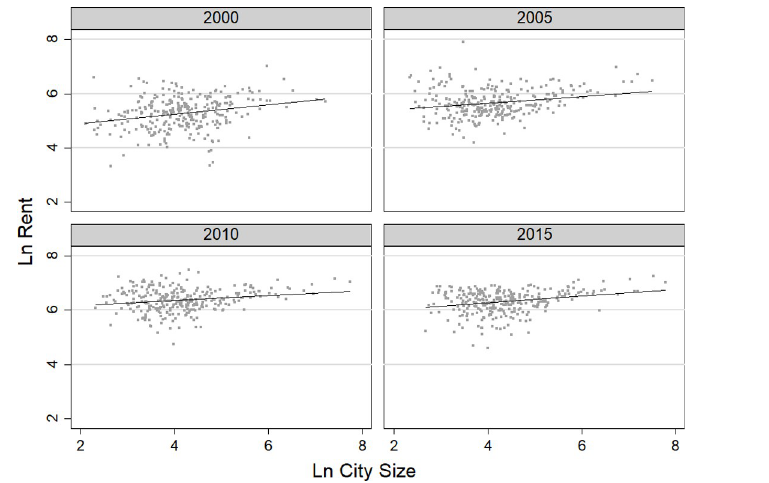
Fig 5. Changes in rent elasticity for migrants from 2000 to 2015.